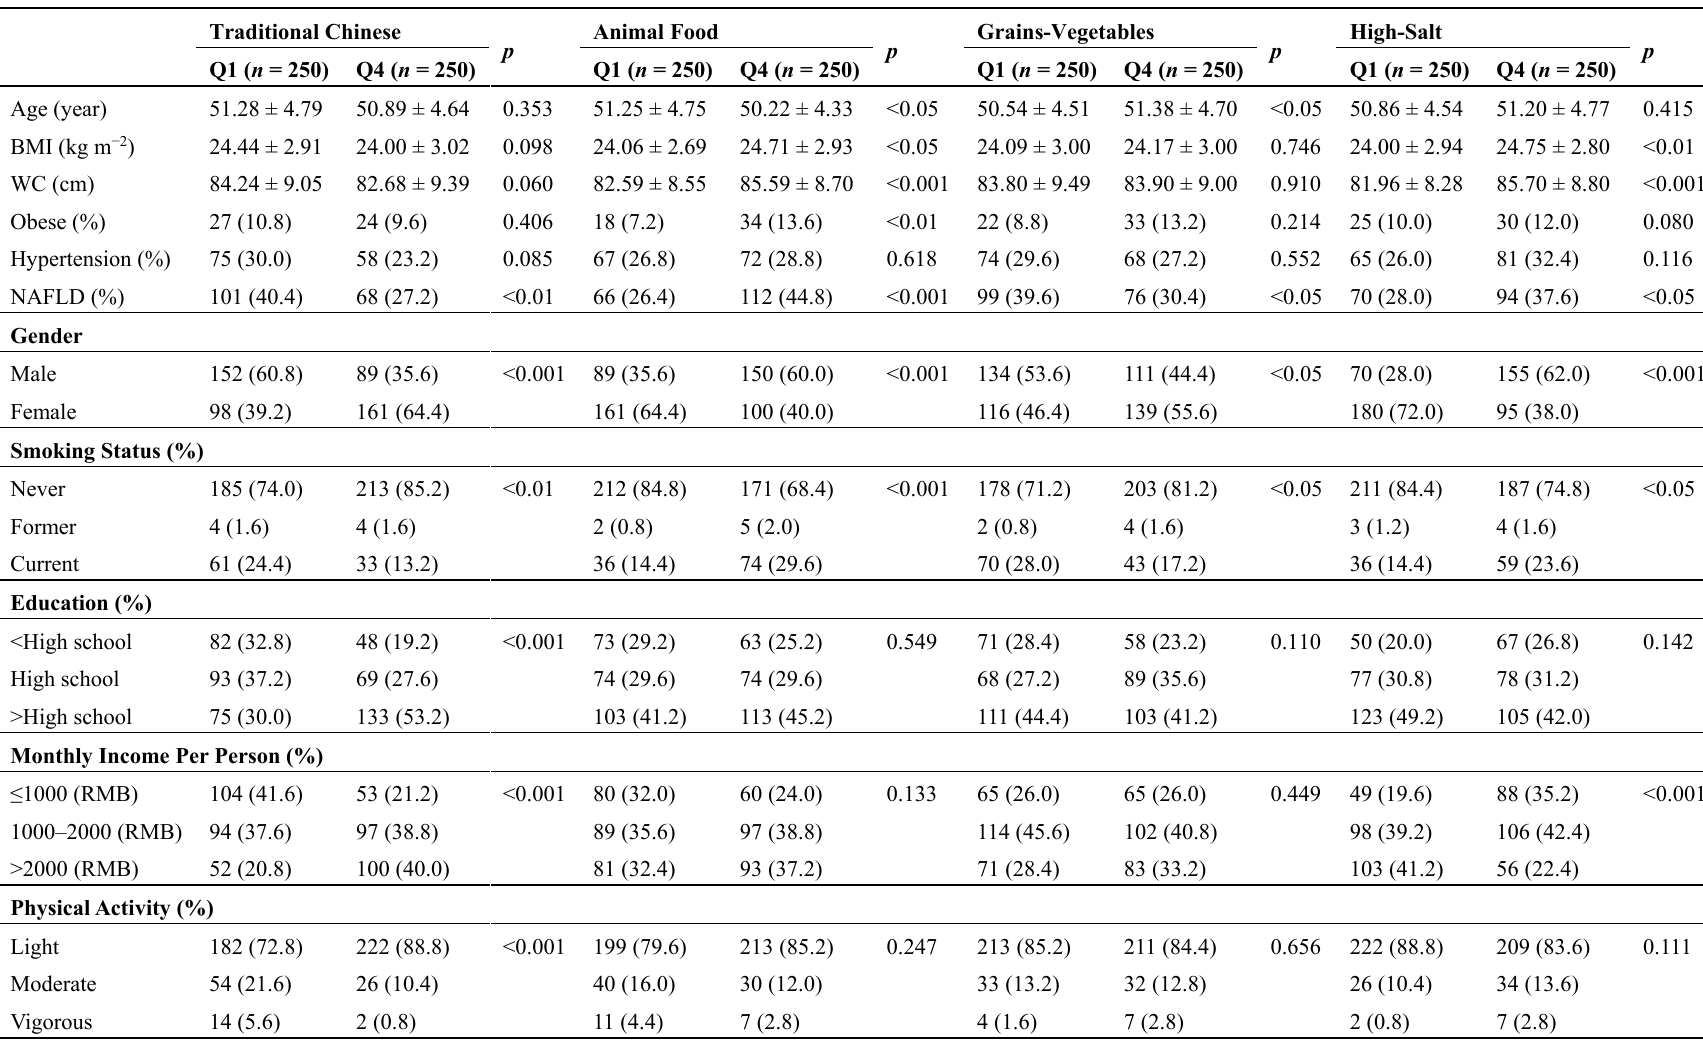
Table 3. Characteristics of the study participants by quartile (Q) categories of dietary pattern scores in the Hefei Nutrition and Health Study. Traditional Chinese Animal Food p p